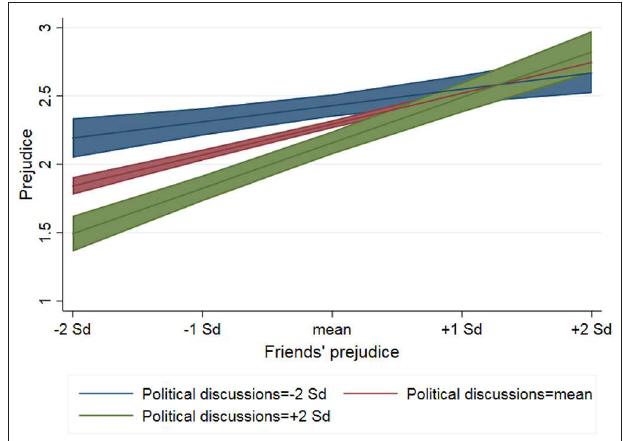
FIGURE 4 | Predicted values from linear mixed repeated measurement model (model 4) with 95% confidence